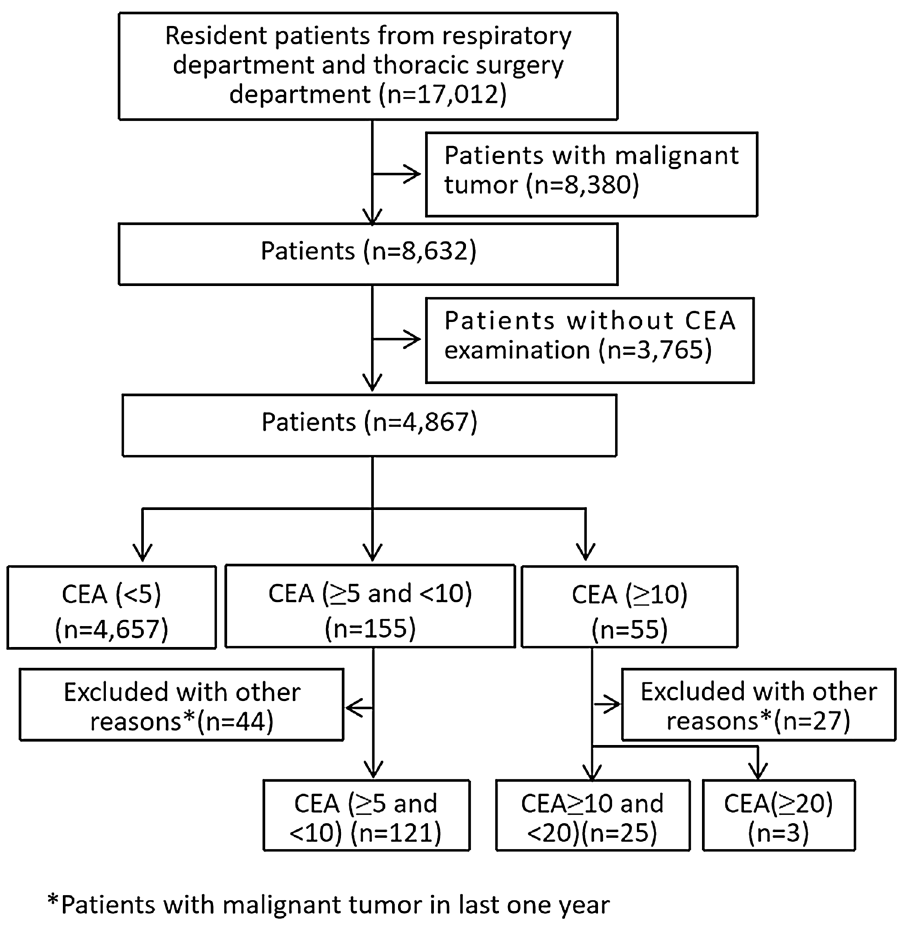
Figure 1. The study flowchart.